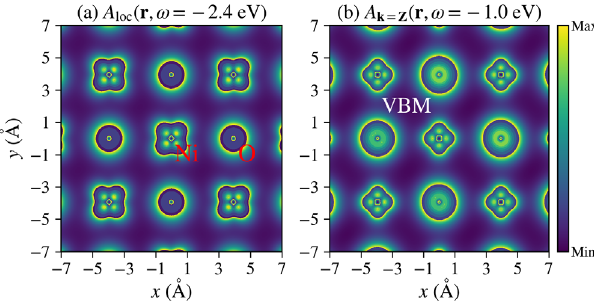
FIG. 5. Full cell GW þ DMFT results for α -Fe 2 O 3 (AFM phase). (a),(b) Local DOS based on PBE and PBE0 references. The experimental spectra are taken from Ref. [94] (exp1) and Ref. [95] (exp2). (c),(d) Orbital-resolved DOS corresponding to (a),(b), respectively. A broadening factor of 0.3 eV is